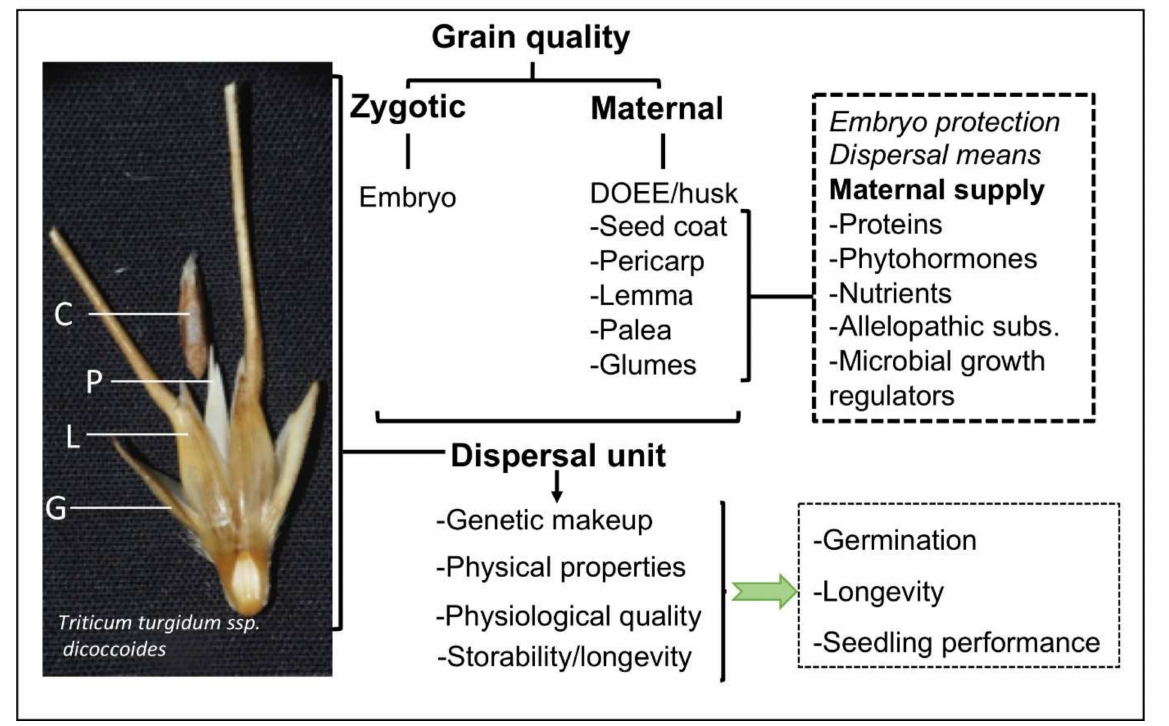
Figure 2. The significance of husks in cereal grain fate and seedling performance. The quality of cereal grains has two facets: zygotic and maternal. The genetic makeup of the embryo (zygotic product) represents the most important factor characterizing grain quality, and together with the maternal DOEE (e.g., husk), represents the dispersal unit. In addition to physical protection and dispersal means, the husks also contribute non-genetic maternal supply including active hydrolytic proteins, phytohormones and allelopathic substances (subs.) that significantly affect physiological quality and storability and consequently germination, longevity and seedling performance. Left panel is the DU (spikelet) of wild emmer wheat. G, glume; L, lemma, P, palea, C,